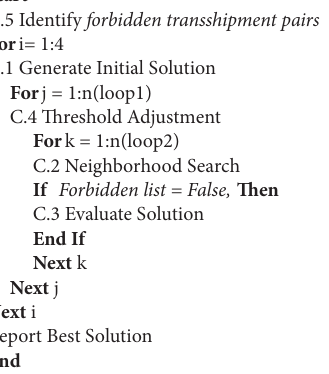
Figure 4: Pseudo-code of the TA-NS